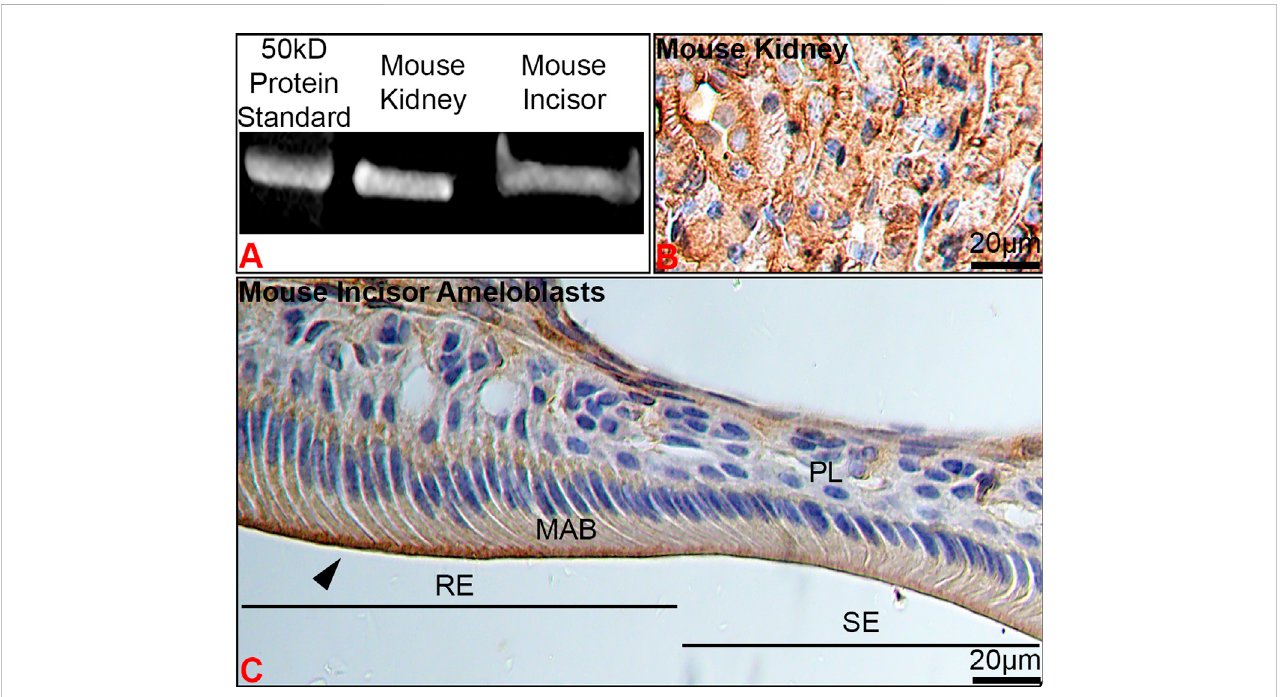
Thestage-andspatial-speci fi cpresenceofKir4.2(Kcnj15)inmaturationameloblasts. (A) Anti-Kir4.2antibodyidenti fi edanapproximately 45 kDaprotein in western blot analysis of mouse kidney and fi rst molar enamel organs. (B) Kidney controls were immunopositive for Kir4.2. (C) Kir4.2 was immunopositive at the apical border of ruf fl e-ended (RE) maturation ameloblasts (MAB), and was reduced in smooth-ended (SE)